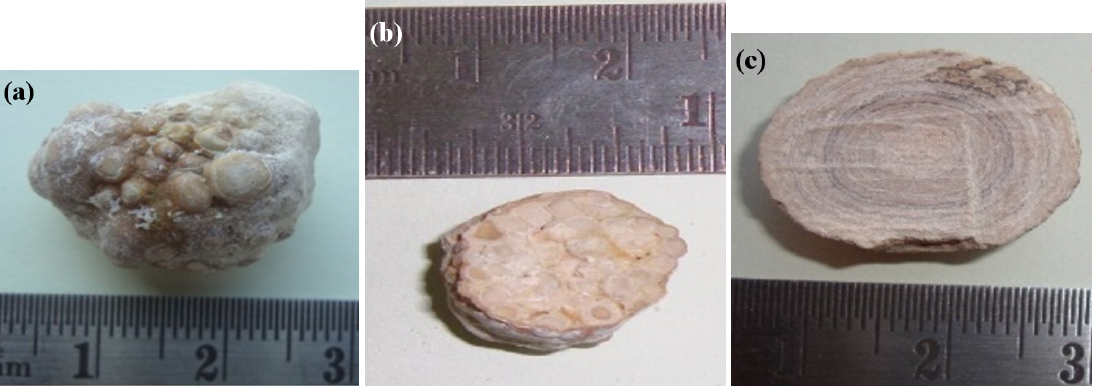
Figure 1. Calcified gallstones: ( a ) granular gallstone and cross-section of ( b ) granular and ( c ) non-granular